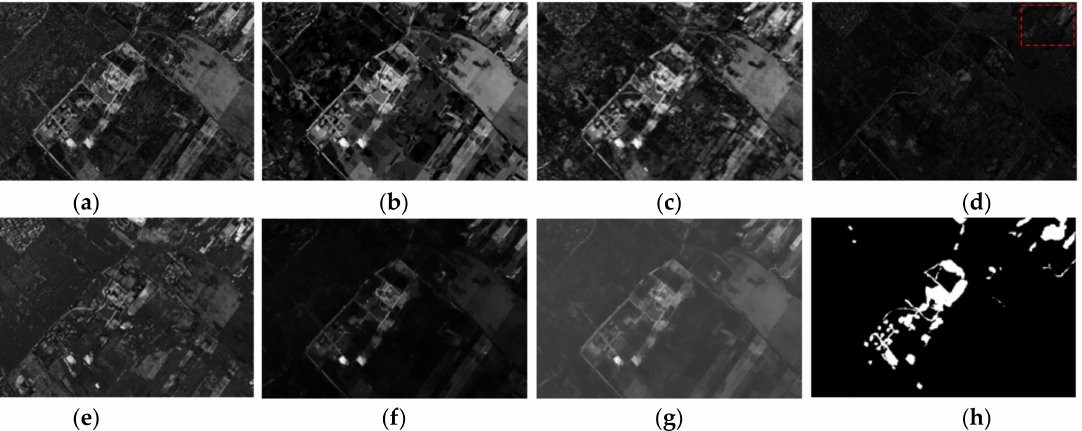
Figure 7. DIs of SZTAKI data set generated by different methods: ( a ) CVA; ( b ) OCVA; ( c )